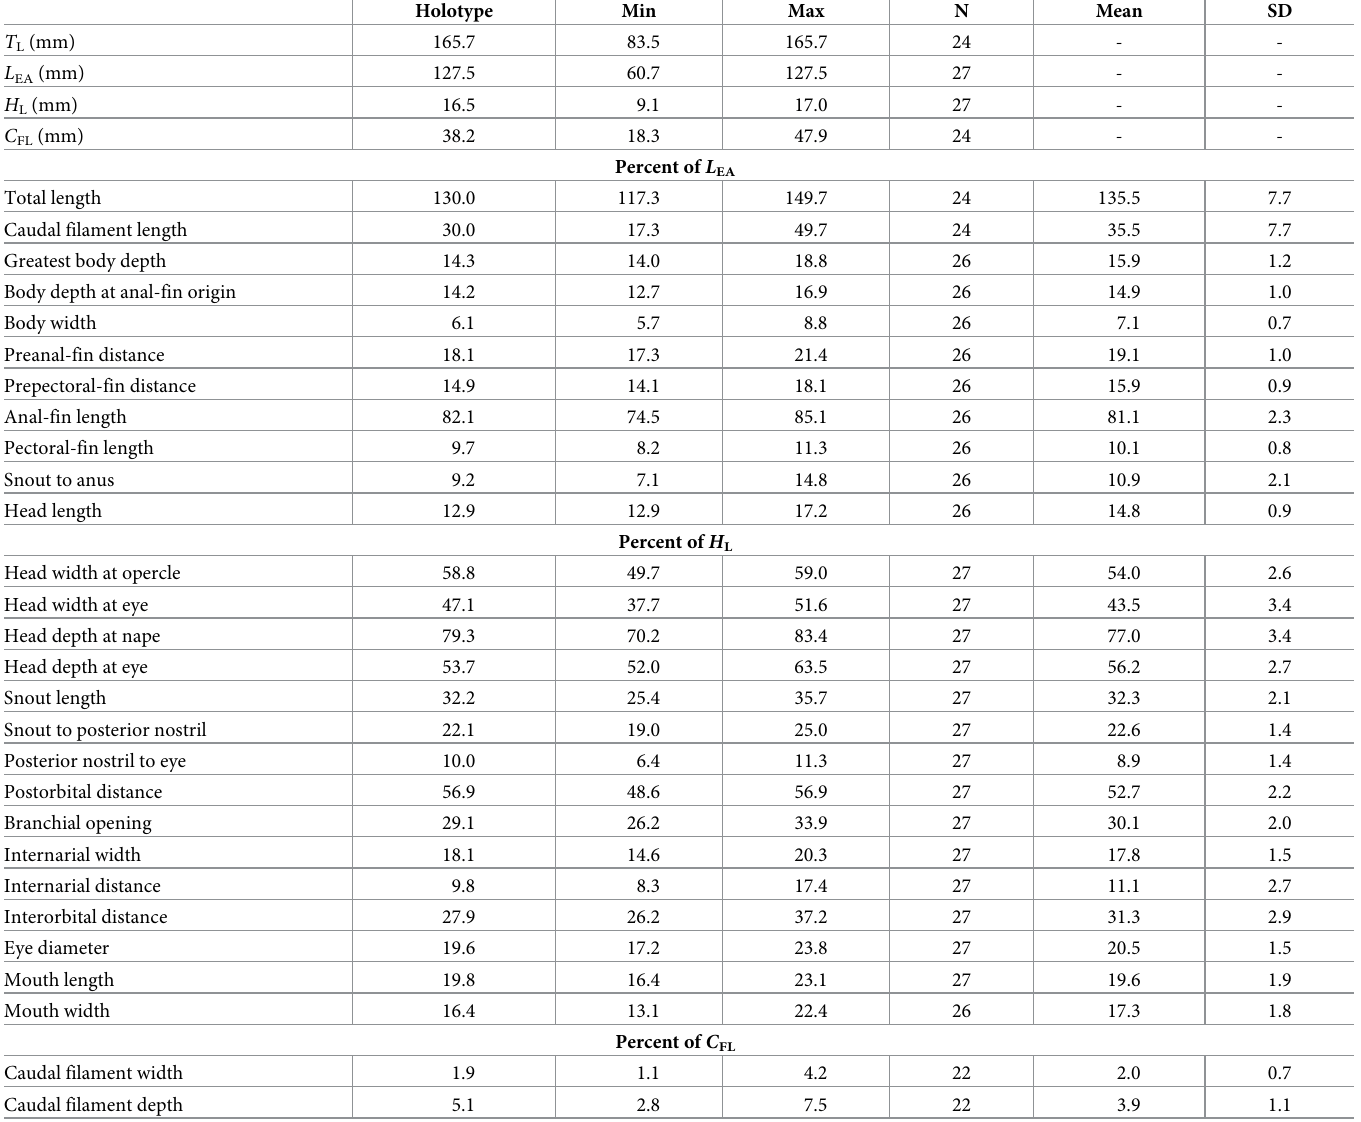
Table 1. Morphometrics for examined specimens of Eigenmannia sirius , new species. SD = Standart